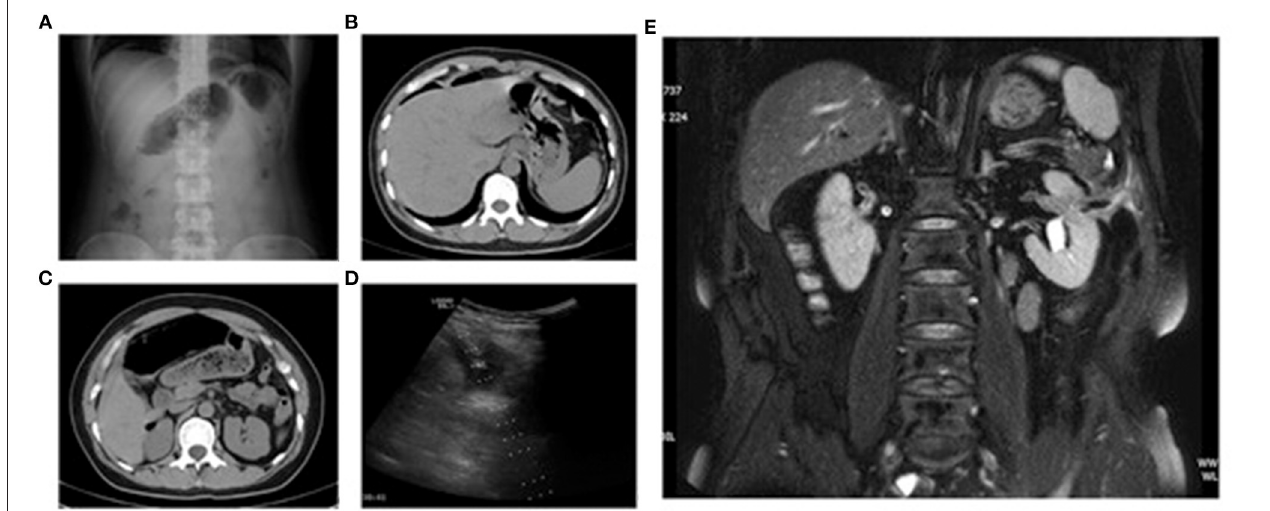
FIGURE 2 | Patient number 7 (A–D) : female, 40 years, myoma in the posterior wall of the uterus. Abdominal radiography (standing) and CT 1 day after microwave ablation showed free intraperitoneal air. Ultrasound showed pelvic effusion, and diagnostic paracentesis was carried out. Patient number 4 (E) : male, 60 years, left renal metastasis of left-lung squamous cell carcinoma. MRI 52 days after microwave ablation showed left perirenal abscess and fistula between the intestines, ablation area, and urinary system. (A) Radiography of the abdomen (standing) 1 day after microwave ablation. (B) CT 1 day after microwave ablation. (C) CT 1 day after